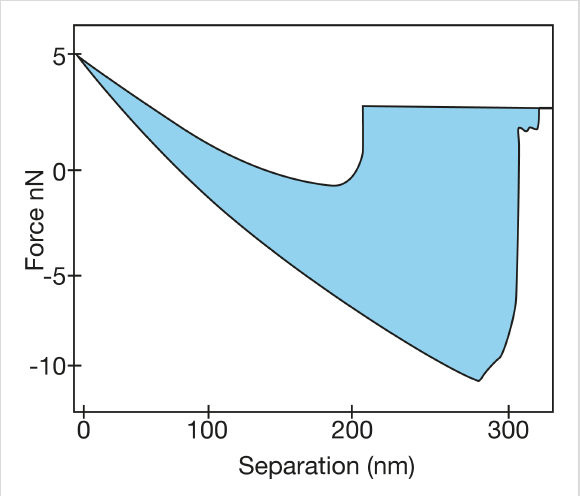
Figure 1: Adhesion-induced hysteretic negative unloading force observed on indenting PDMS (4% cross-linked) by AFM with a pyra- midal silicon nitride tip of force constant 0.05 N/m. The colored area represents the hysteresis between ingoing- and outgoing traces and defines the energy